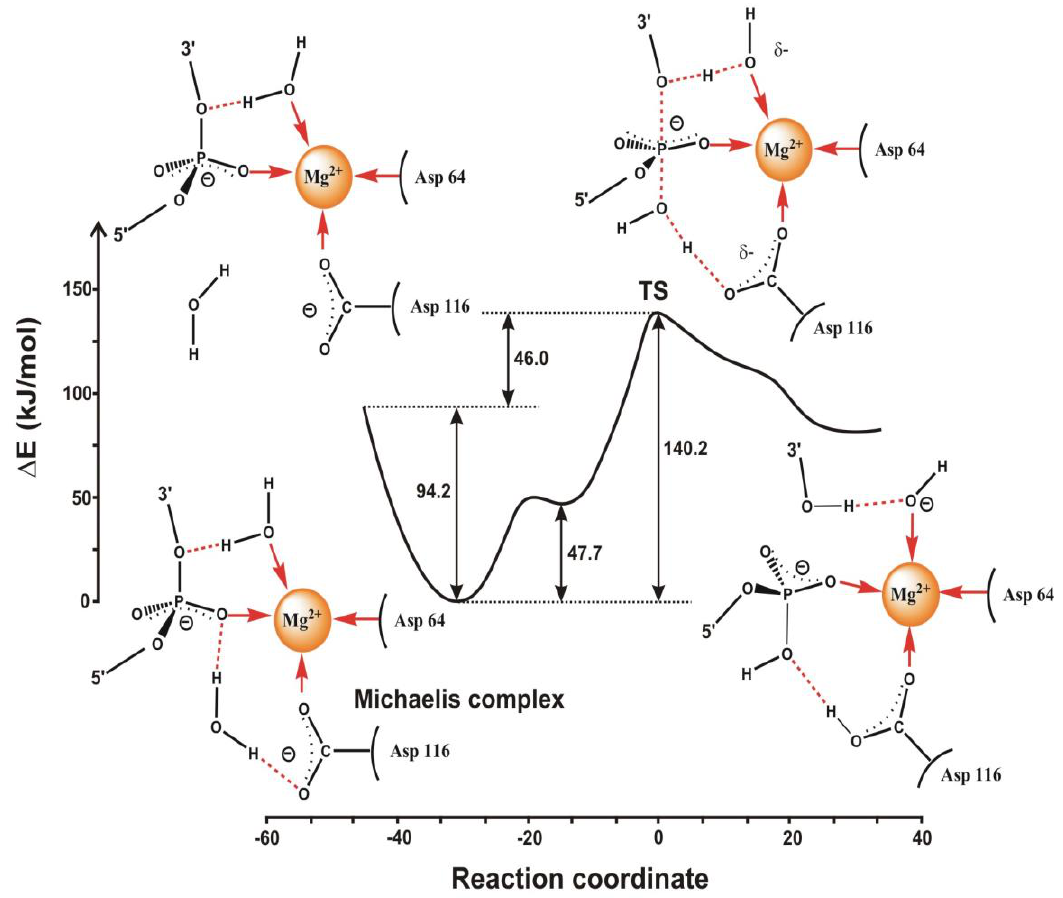
Figure 6. Quantum mechanically calculated reaction profile for the phosphoryl transfer reaction catalyzed by HIV integrase (figure drawn on the basis of Ref.